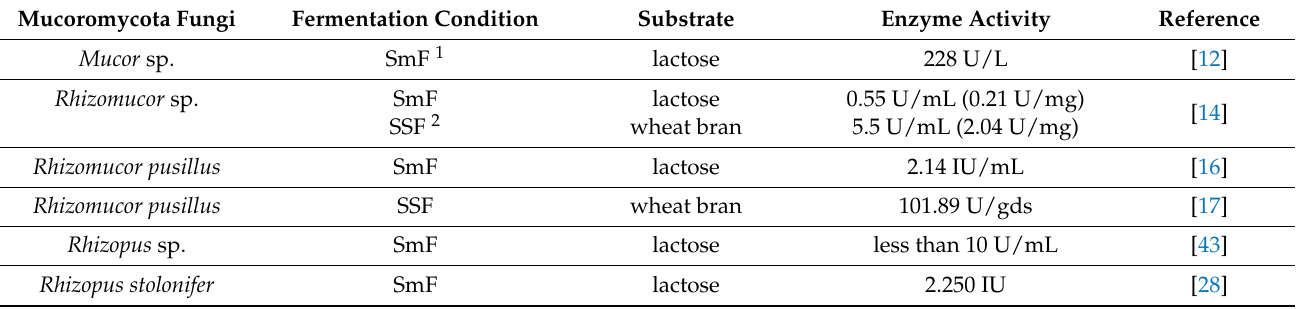
Table 4. β -Galactosidase production of Mucoromycota, applied fermentation conditions, growth substrates, and the enzyme activity